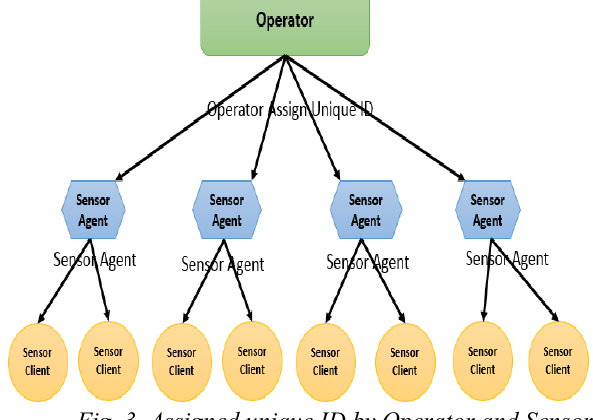
Fig. 3. Assigned unique ID by Operator and Sensor